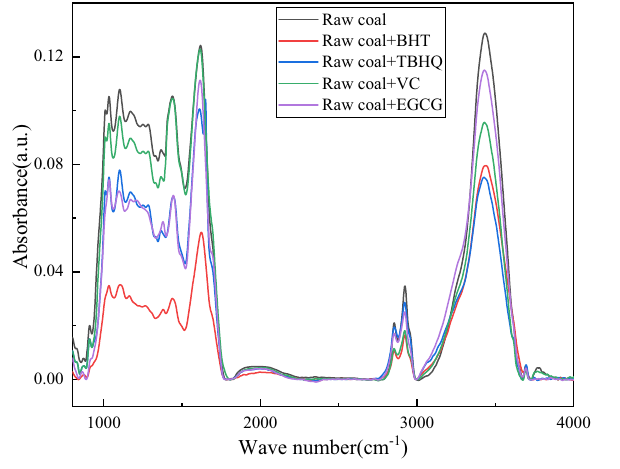
Figure 3. Infrared spectrum.